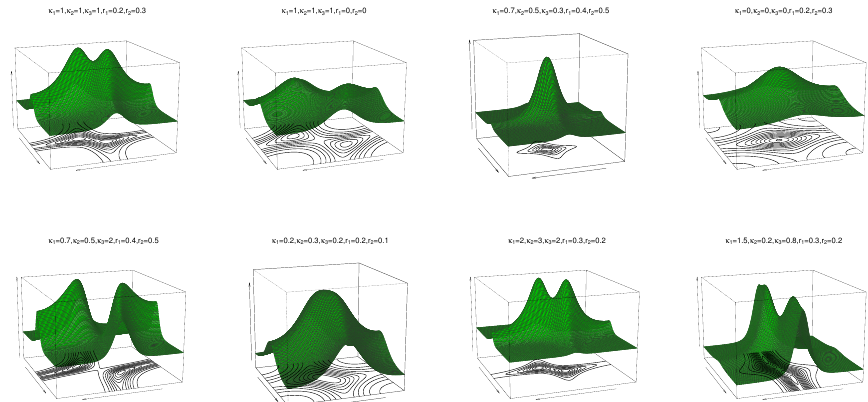
Figure 2. Pdf and contour plots of the transformed cosine model (10) for µ 1 = µ 2 = 0 and different values of κ 1 , κ 2 , κ 3 , r 1 , and r 2